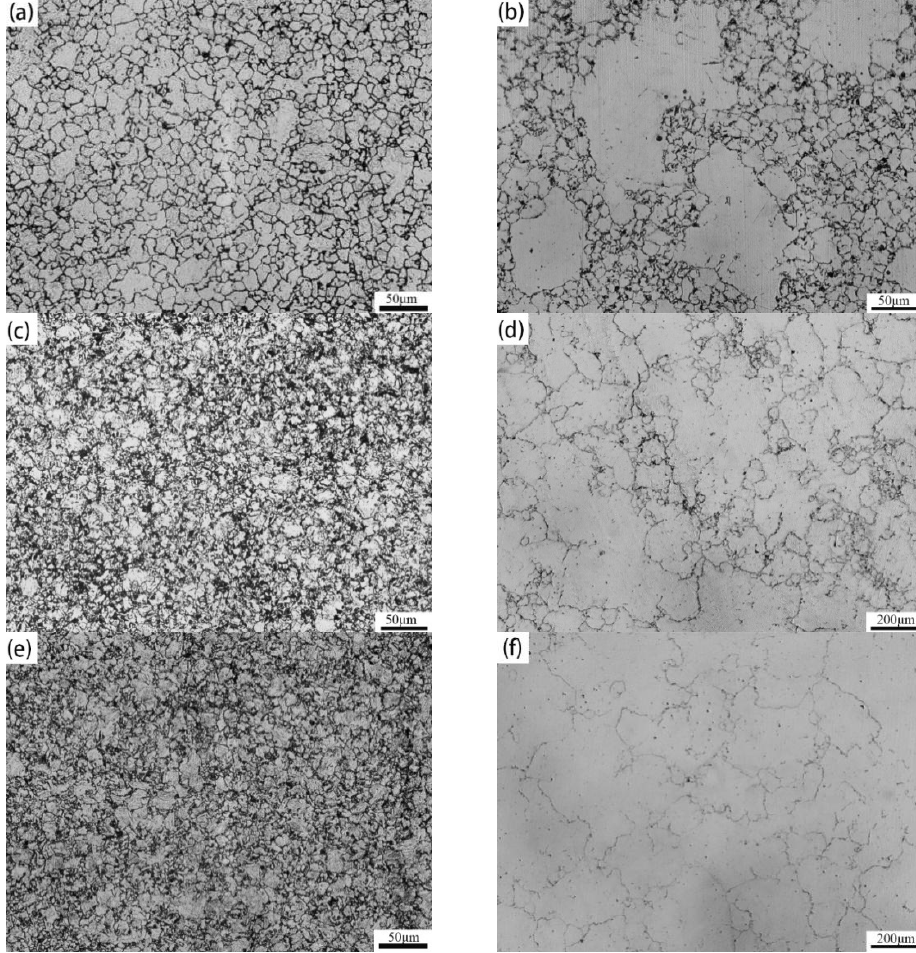
Figure 2. Examples of optical micrographs showing austenite grain structures after pseudo-carburizing at different temperatures for 0.5 h, 3 h, and 5 h; ( a ) 950 °C for 0.5 h; ( b ) 1050 °C for 0.5 h; ( c ) 950 °C for 3 h; ( d ) 1050 °C for 3 h; ( e ) 950 °C for 5 h; ( f ) 1050 °C for 5 h.